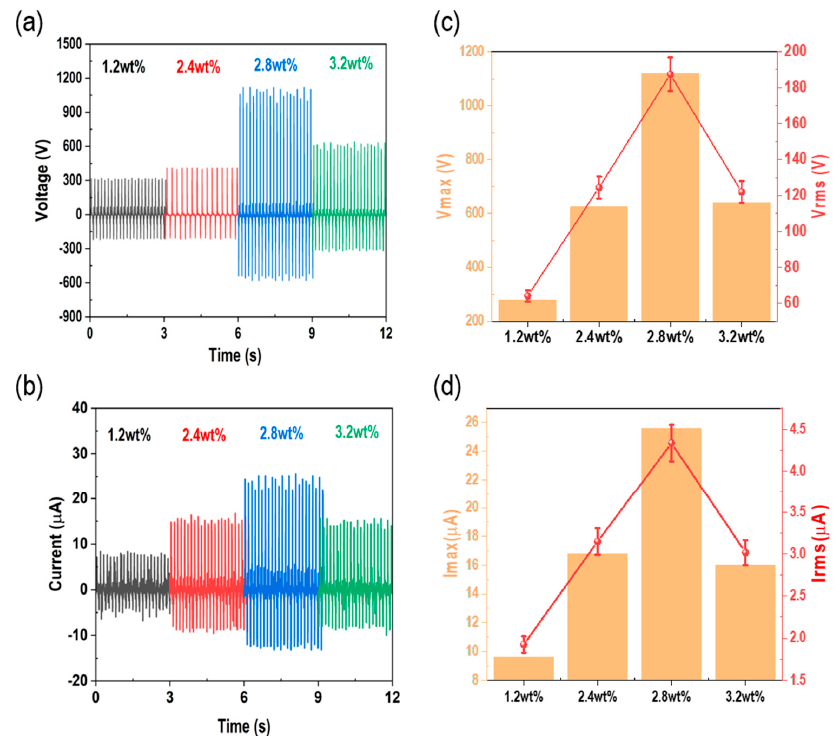
Figure 4. Evaluation of FCS-TENG output performance according to CNT ratio. ( a , b ) Voltage and current output graph from 1.2 to 3.2 wt%, and ( c , d ) maximum value and RMS value graph from 1.2 to 3.2 wt%.